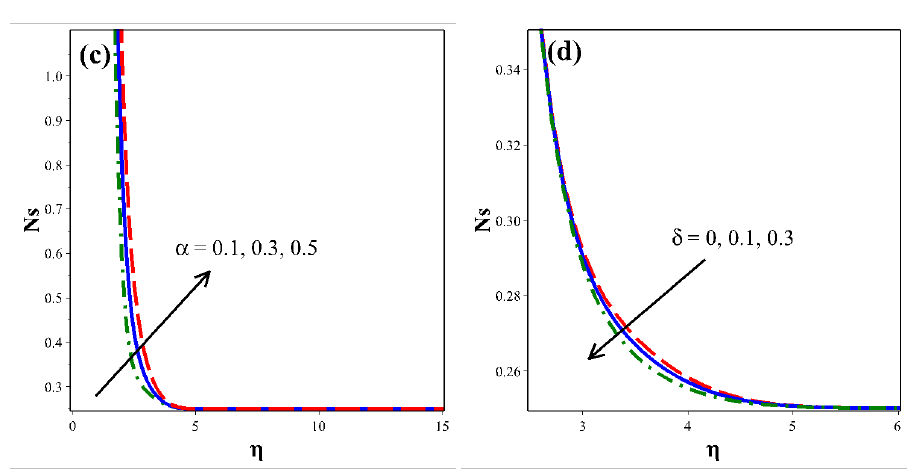
Fig. 6: Influence of Reynolds number, magnetic parameter, second grade parameter and thermal slip parameter on entropy generation